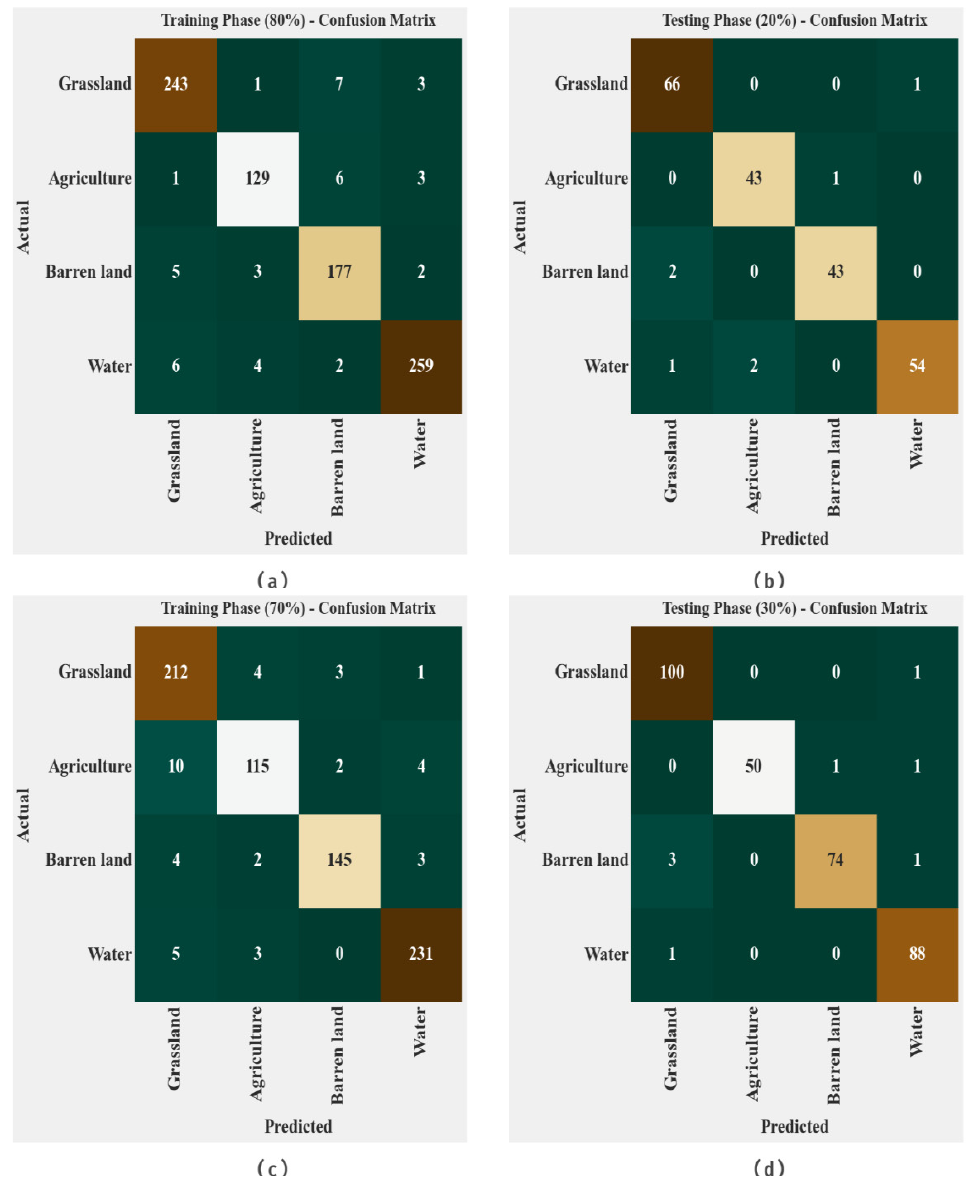
Figure 4. Confusion matrices of TSADL-LULCCD method ( a , b ) TR and TS databases of 80:20 and ( c , d ) TR and TS databases of 70:30.